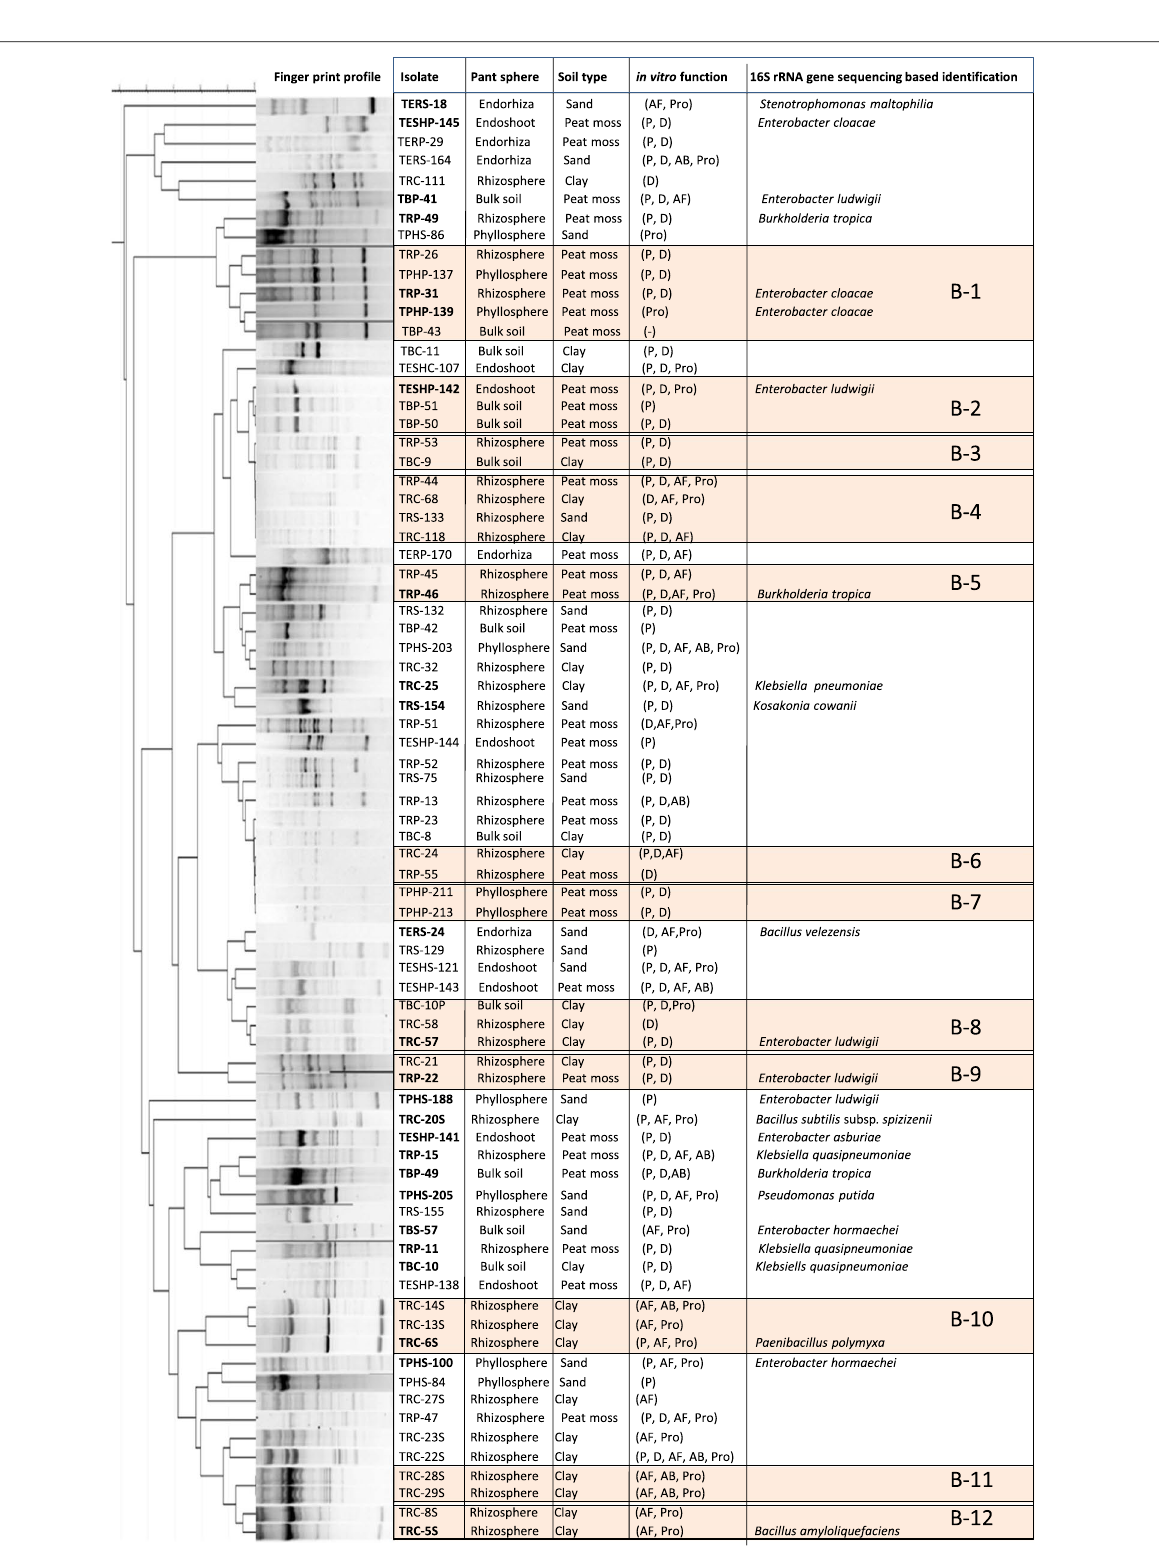
Fig. 1 Dendrogram showing the UOGMA analysis between BOX PCR fingerprint